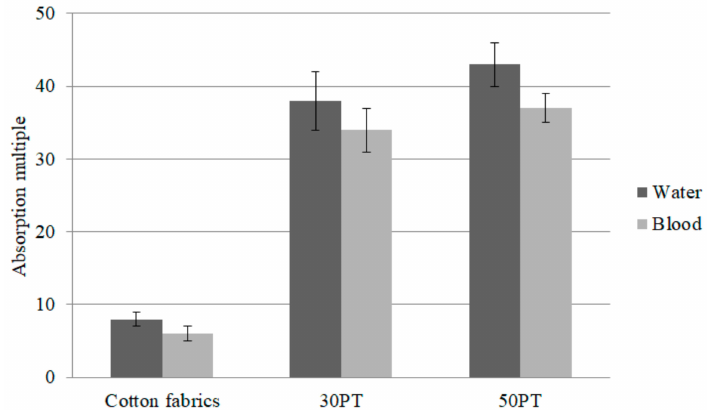
Figure 11. Moisture and blood absorption performances of polyacrylate/Tencel ® nonwoven compos- ites as related to the content of polyacrylate